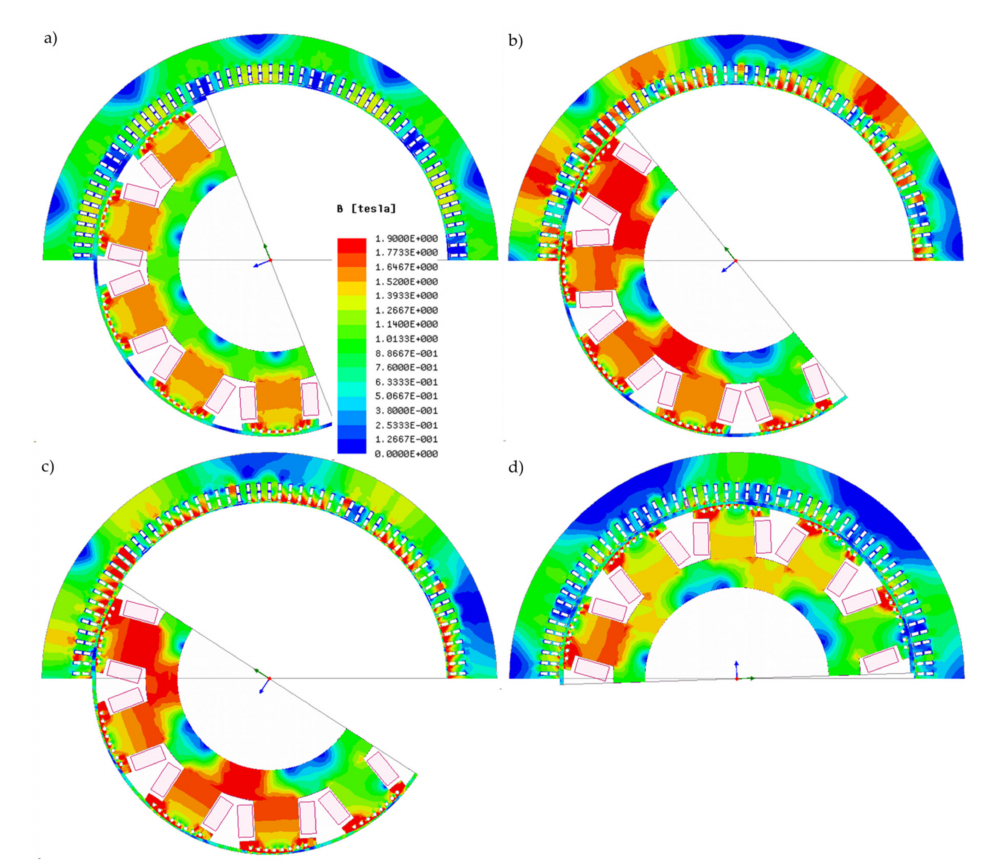
Figure 24. Flux densities during out-of-phase synchronization of − 120 ◦ at ( a ) 0.02 s, ( b ) 0.025 s, ( c ) 0.03 s, and ( d ) 0.302